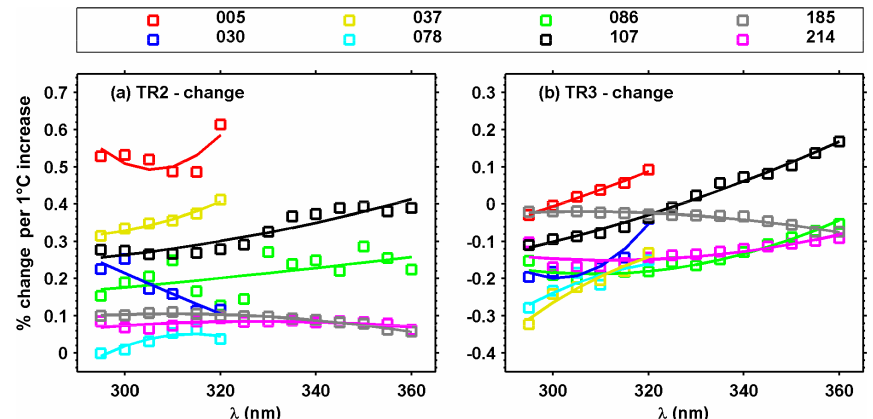
Figure 4. Change (in %) of irradiance for 1 ◦ C increase in temperature as a function of wavelength for (a) TR2 and (b) TR3 for the eight